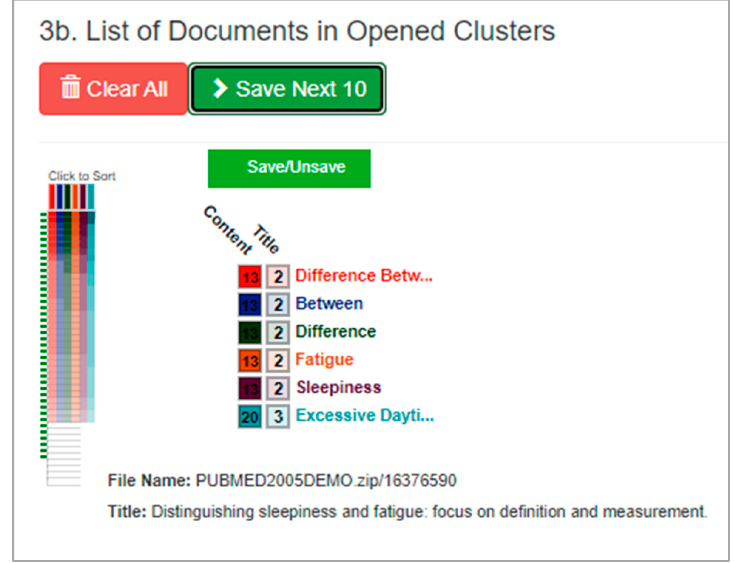
Figure 12. A close look at high-level triage, showing a listing of documents contained within a se- lected grouping of the document set.